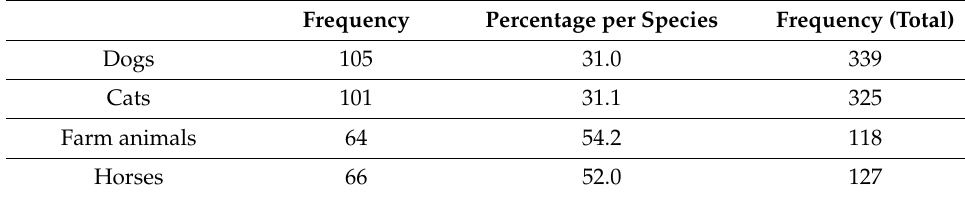
Table A7. Frequency and percentage of diplomates per species.